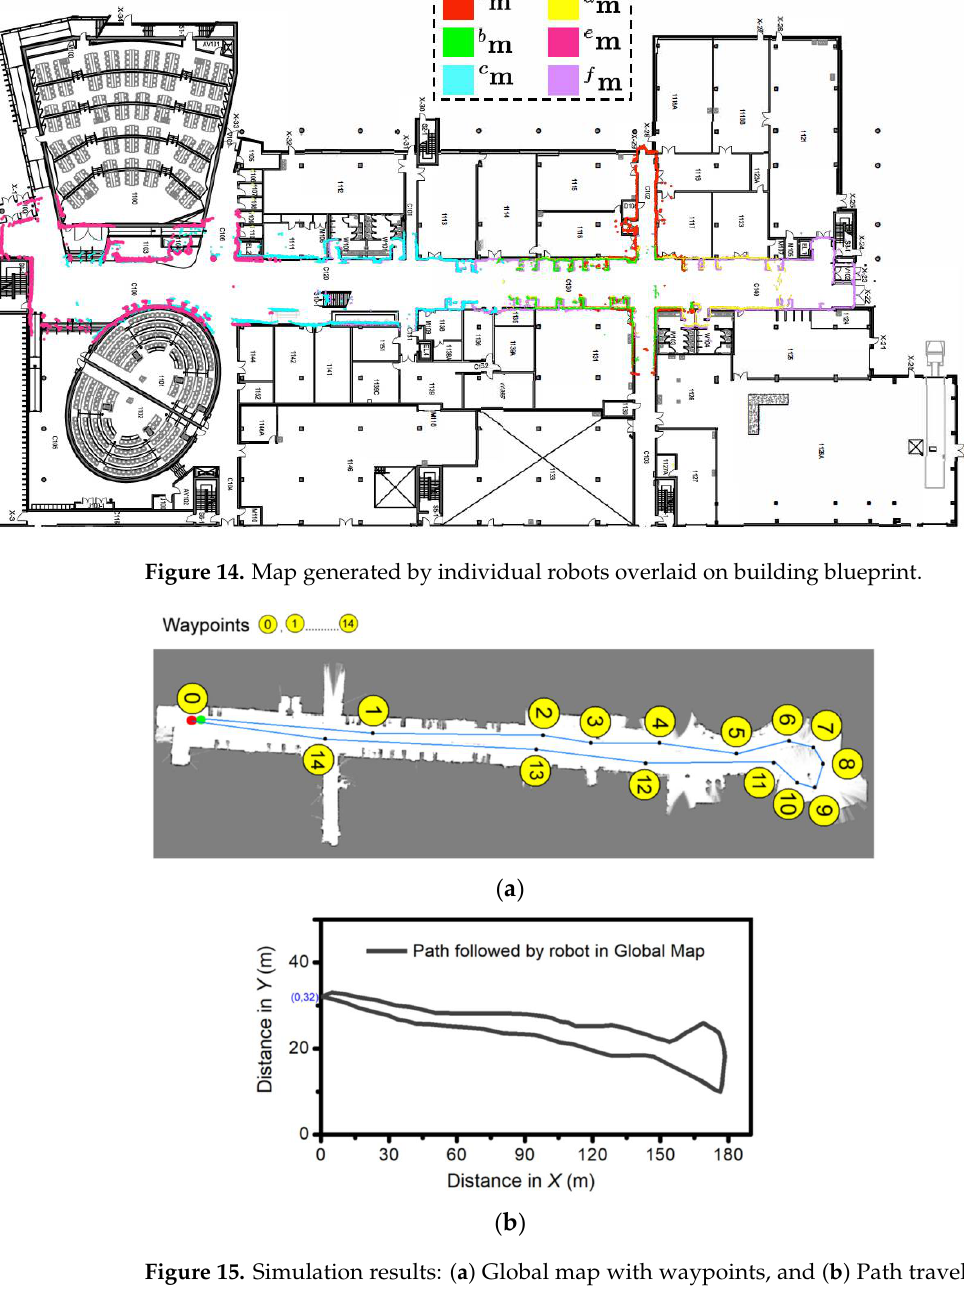
Figure 15. Simulation results: ( a ) Global map with waypoints, and ( b ) Path travelled by the robot during navigation in global map in ROS environment.